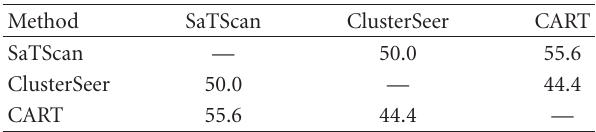
Table 2: Percentage of common hotspots identified by di ff erent